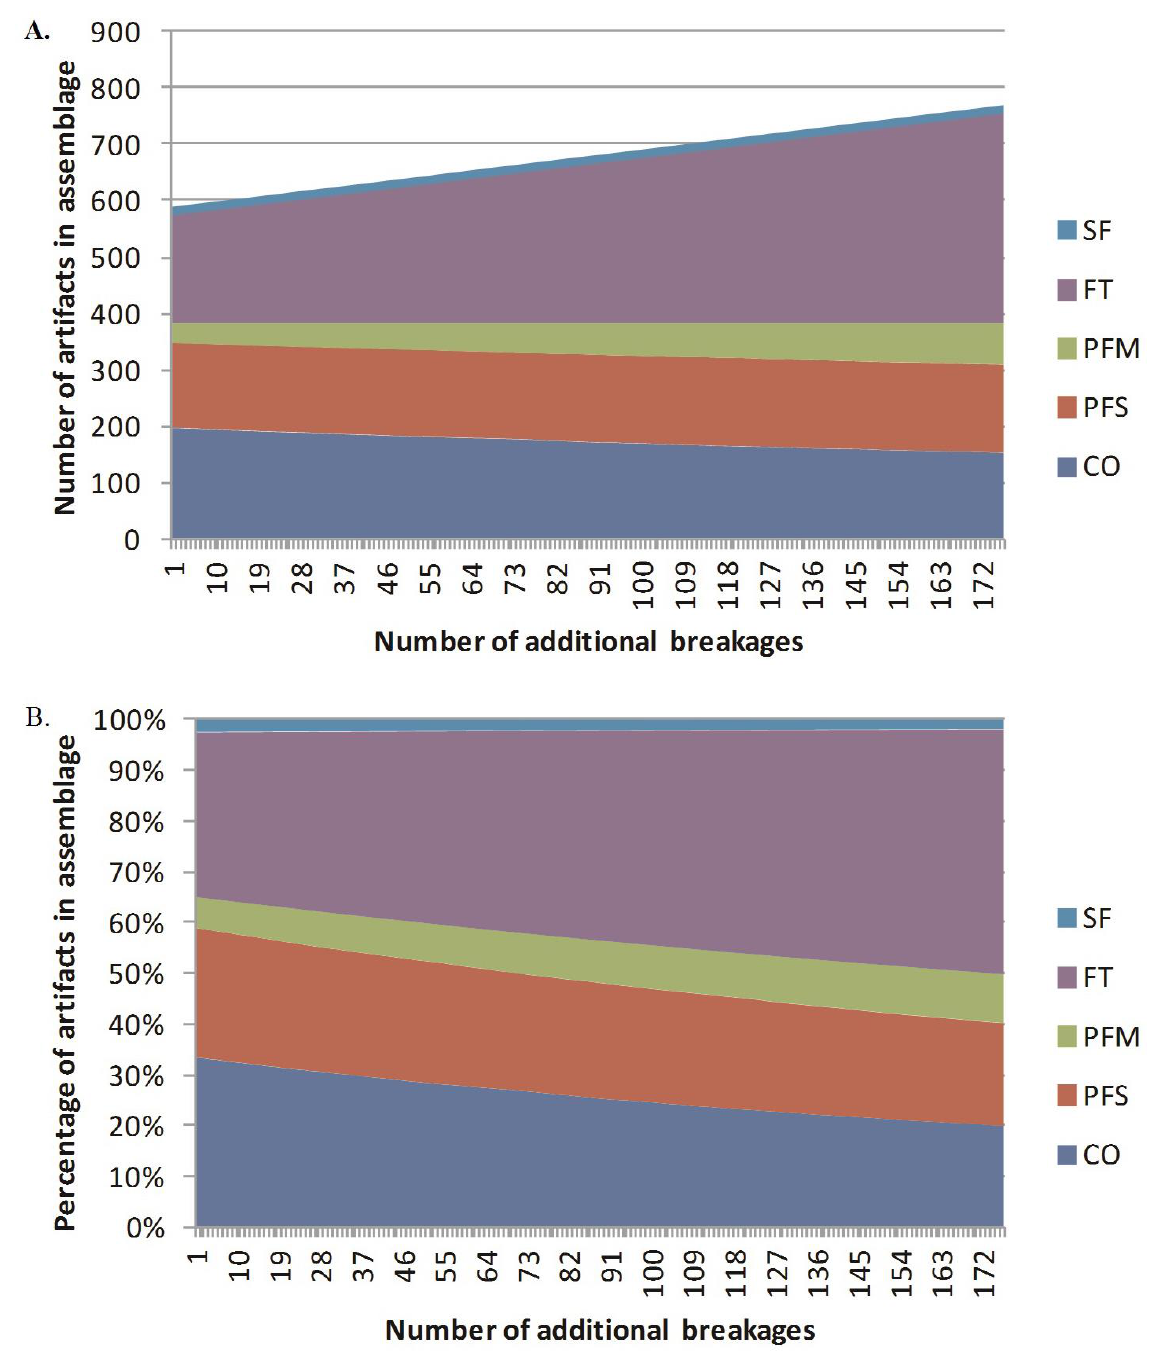
Figure 4. Curves representing changes to the breakage patterns with increasing number of additional breakages caused by a post-depositional process. Notice the increase in the absolute number of artifacts in the assemblage. A. Absolute change in the breakage categories. B. Proportional change in breakage